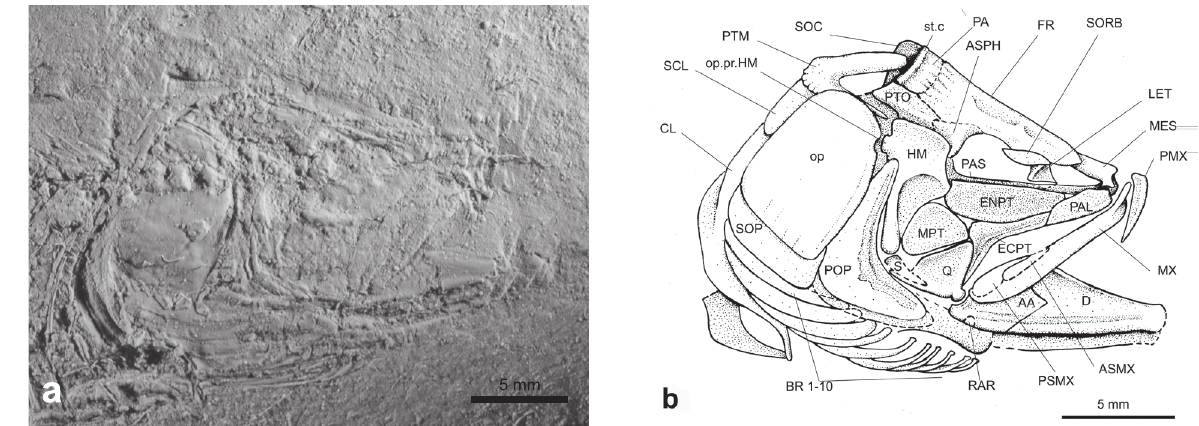
Figure 5 . † Scutatuspinosus itapagipensis Santos and Corrêa 1985: ( a ) photograph of DGM 1255-P; ( b ) interpretative line-drawing of skull and pectoral girdle of DGM